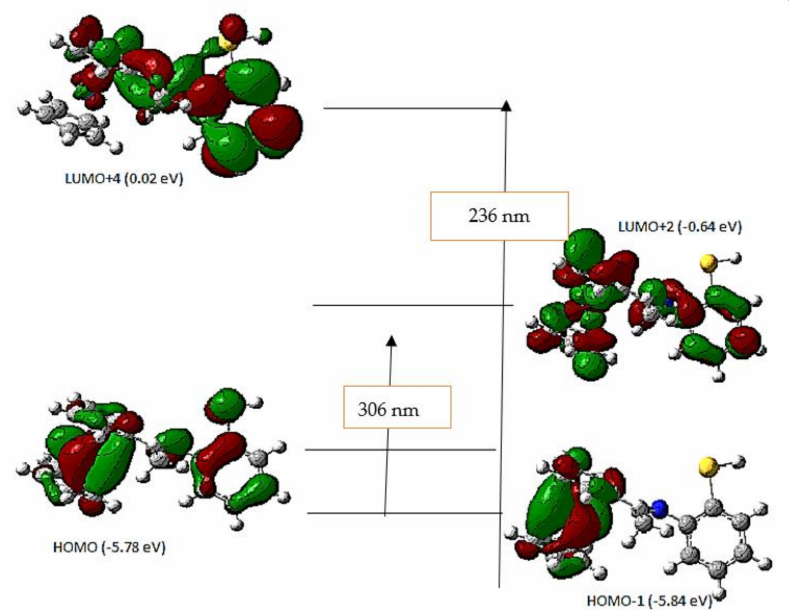
Figure 2. Possible molecular orbitals’ transitions of the acetyl ferrocene imine